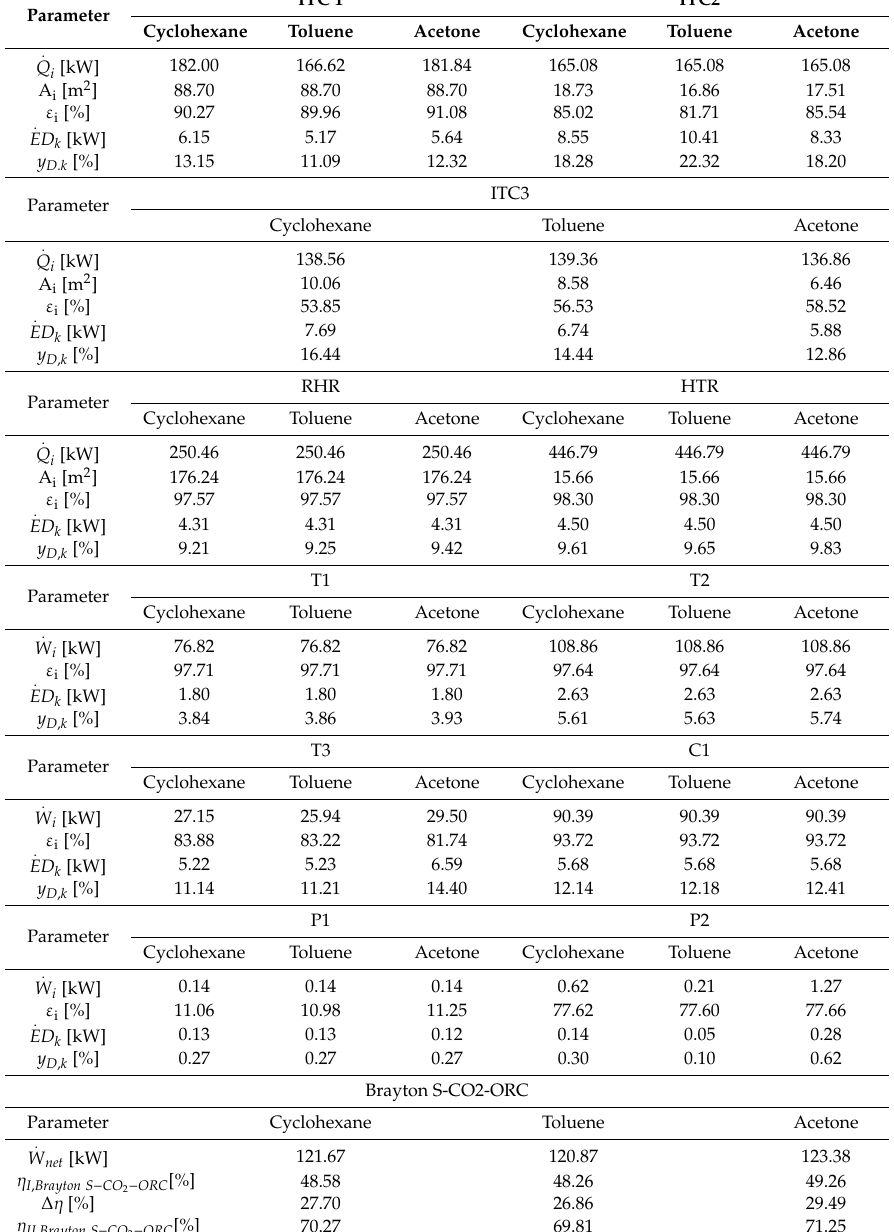
Table 2. Exergy e ffi ciency, destroyed exergy, destroyed exergy ratio of each equipment, and heat exchanger